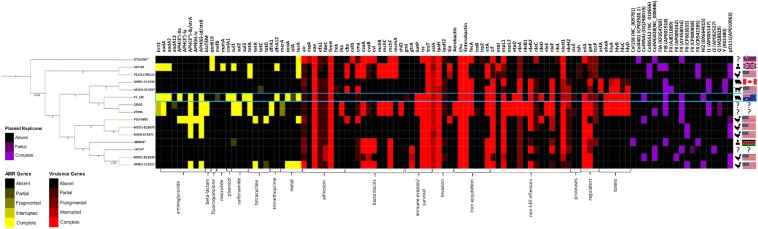
Heatmap and SNP tree of ST302 virulence factors, antimicrobial resistance and plasmid replicons. Intact genes are represented in solid colors, while partial, fragmented or interrupted genes are less opaque. Partial, fragmented and interrupted genes encompass all non-intact genes. ARGs and heavy metal resistance genes are shown in yellow, VAGs in red, and plasmid replicons in purple. Host and country of origin depicted on the right. F2_18C boxed in blue. Tree branch colors are representative of host – red = human; yellow = poultry; green = canine; blue = porcine; black = unspecified. ∗Indicates an abbreviated strain name: 400654∗ = Escherichia_coli_400654-sc-2012-01-13T20:11:31Z-1332520; DTU2016∗ = DTU2016_526_ PRJ1050_ Eschericha_coli_Isol133. The phylogenetic tree was produced by SNP-based phylogenetic analysis.